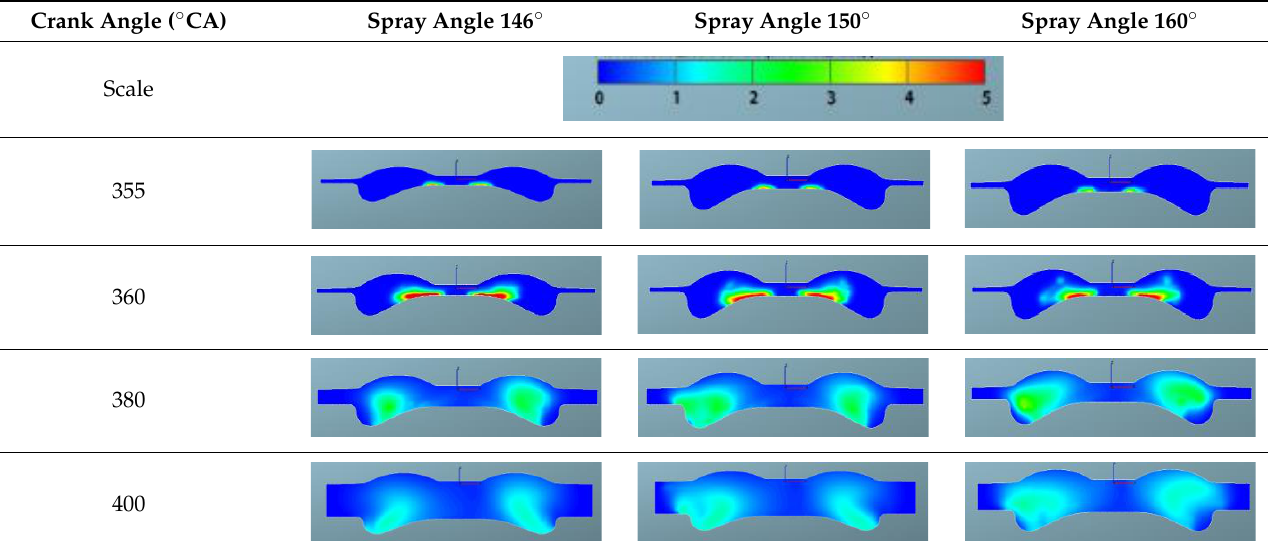
Table 11. Comparison of the equivalence ratio distribution for the F1 combustion chamber combined with three spray